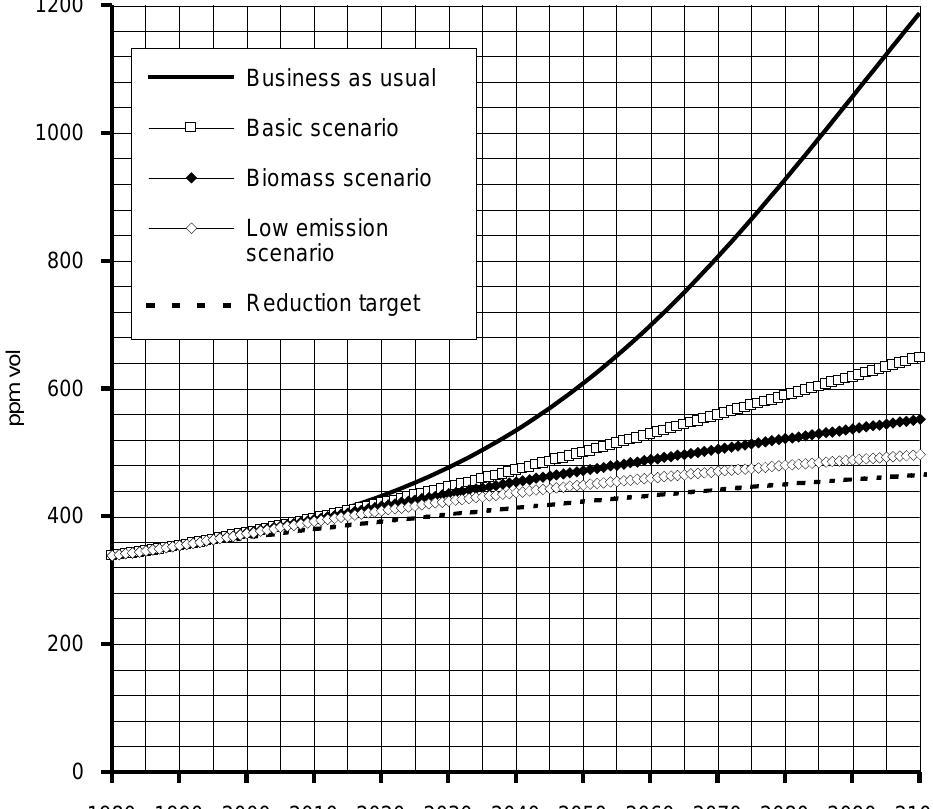
Figure 11. Compilation of several scenarios that allow the evaluation of whether biomass energy is systematically carbon neutral, or the extent to which this carbon neutrality is smaller than antici- pated.